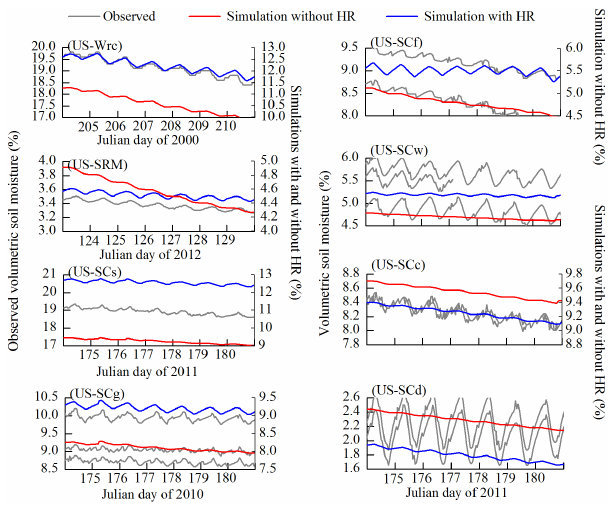
Figure 2. Observed and simulated soil moisture for depth of 0– 30cm during dry